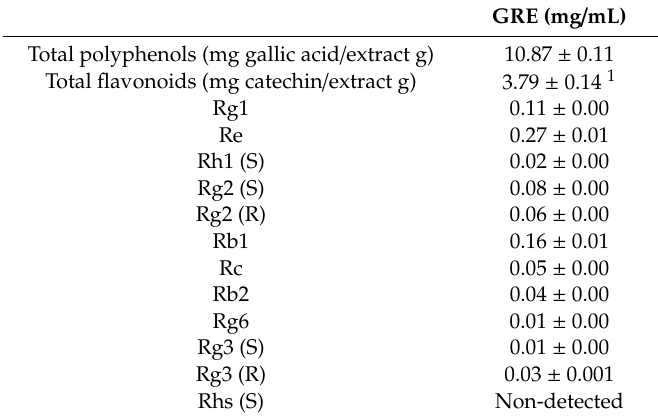
Table 2. Total polyphenol, flavonoid, and ginsenoside contents of ginseng roots extract